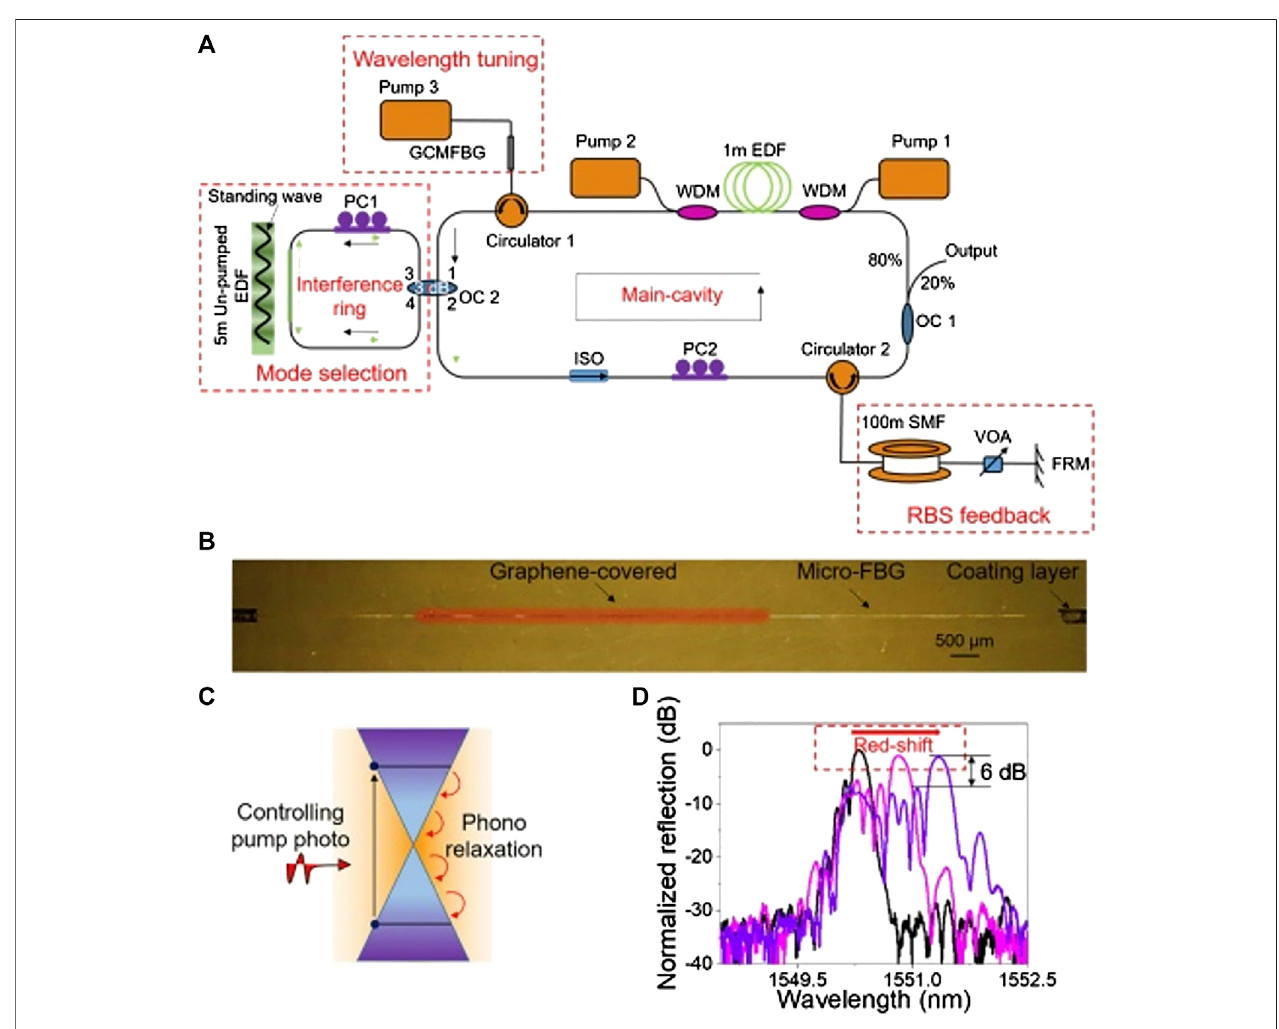
FIGURE 12 | (A) The setup of an optically tunable ultra-narrow linewidth fi ber laser; (B) Photograph of a graphene-coated micro FBG (GCMFBG). The red shaded areaiscoatedwithgraphene. (C) Thephononrelaxationprocessofgraphene; (D) Thered-shiftedre fl ectionspectrumofGCMFBG,whosecontrolopticalpoweris26.8, 64.3 and 101.5 mW. Copyright 2018, Optical Society of